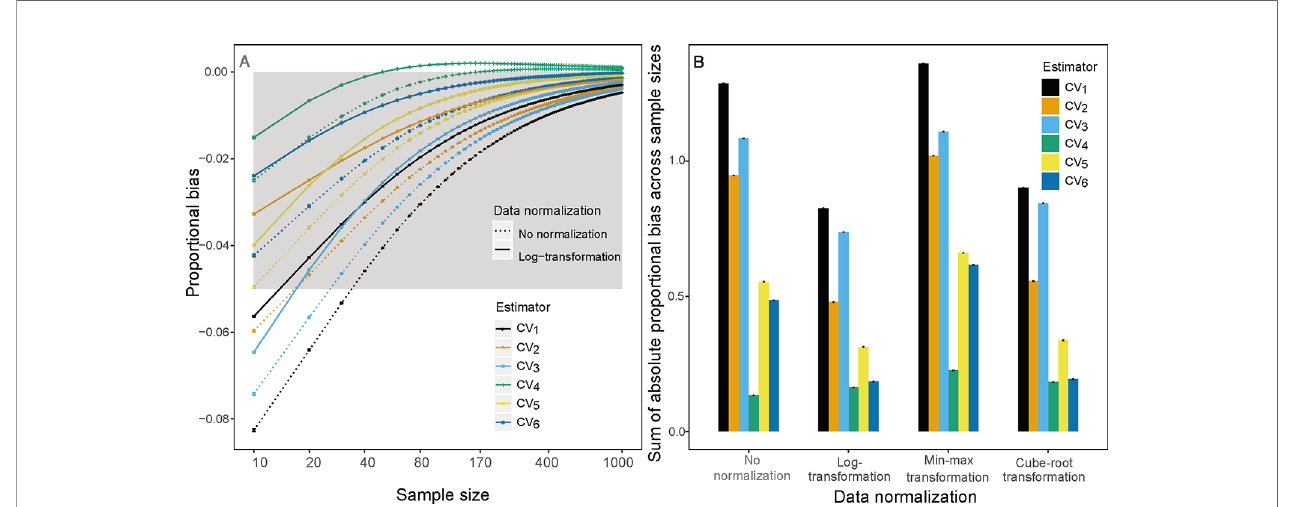
FIGURE 1 | (A) Proportional bias on sample size k ( k ∈ {10,20,30, … 1,000}) based on raw (dotted line) and log-transform (solid line) simulated trait values and (B) sum of absolute proportional bias across all sample size for the i th ( i ∈ {1,2,3,4,5,6})CV estimator based on raw, log-transform, min-max transform and Cube-root transform simulated trait values. Gray area is the region in which the absolute mean proportion of bias is less than